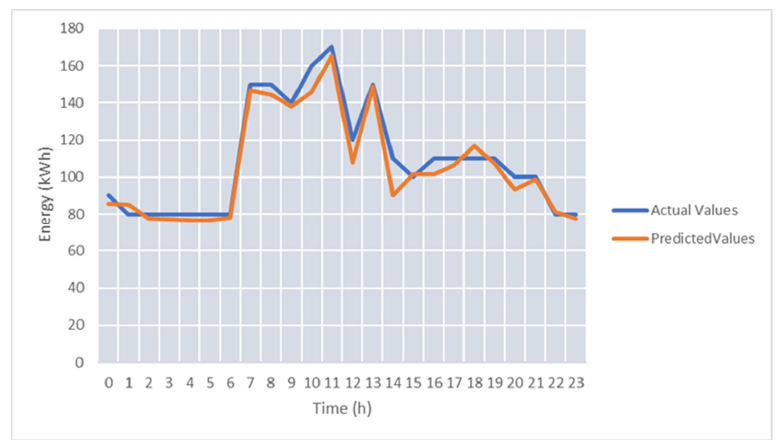
Figure 15. TC-M2: best predicted day (SMAPE = 4.7%).